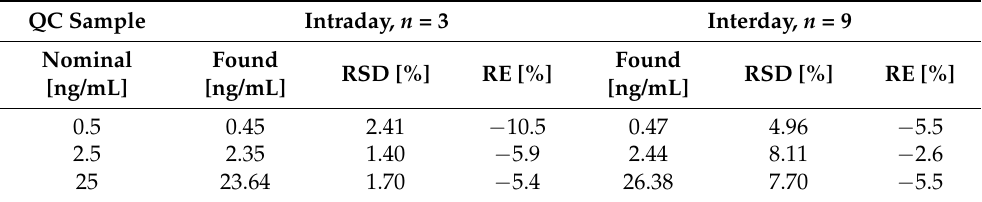
Table 3. Precision (%RSD) and accuracy (%RE) of the developed SPE–UHPLC–MS/MS method from the analysis of QC samples in Surine TM